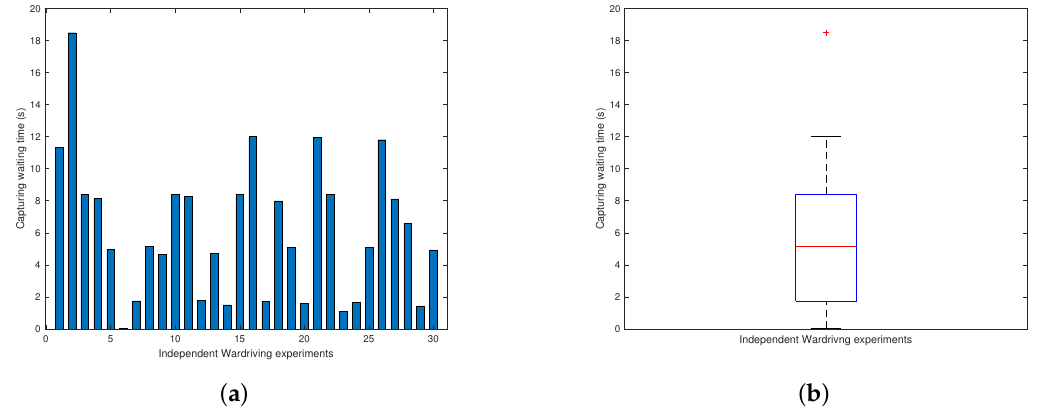
Figure 9. MAC capturing waiting time in wardriving experiments. ( a ) Time for each experiment; ( b ) Time distribution box